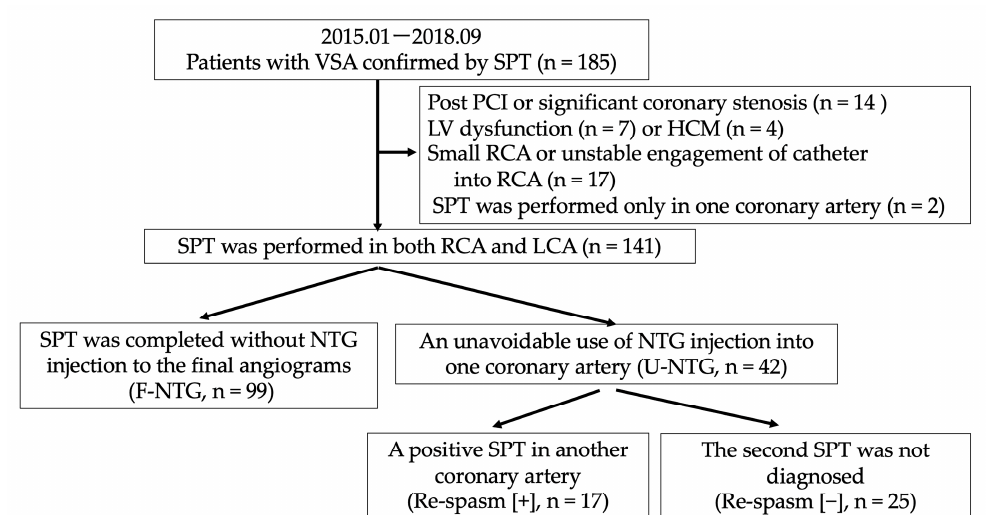
Figure 1. Flowchart of the study protocol. F-NTG, final use of nitroglycerin; HCM, hypertrophic cardiomyopathy; LCA, left coronary artery; LV, left ventricle; NTG, nitroglycerin; PCI, percutaneous coronary intervention; RCA, right coronary artery; SPT, spasm provocation test; U-NTG, unavoidable use of nitroglycerin; VSA, vasospastic angina.